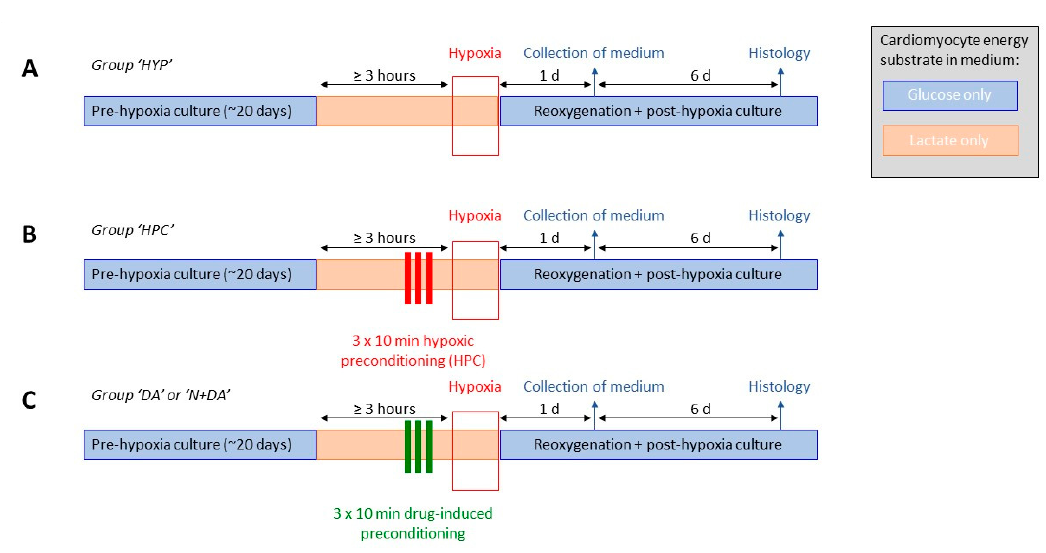
Figure 1. Study design and di ff erent hypoxia-reoxygenation experimental groups. ( A ) Hypoxia- reoxygenation alone (HYP) or ( B ) preceded by hypoxic preconditioning (HPC) or ( C ) preceded by drug-induced preconditioning (with [ D -Ala2, D -Leu5]-Enkephalin (DADLE): DA, or Naloxone and DADLE: N+DA).